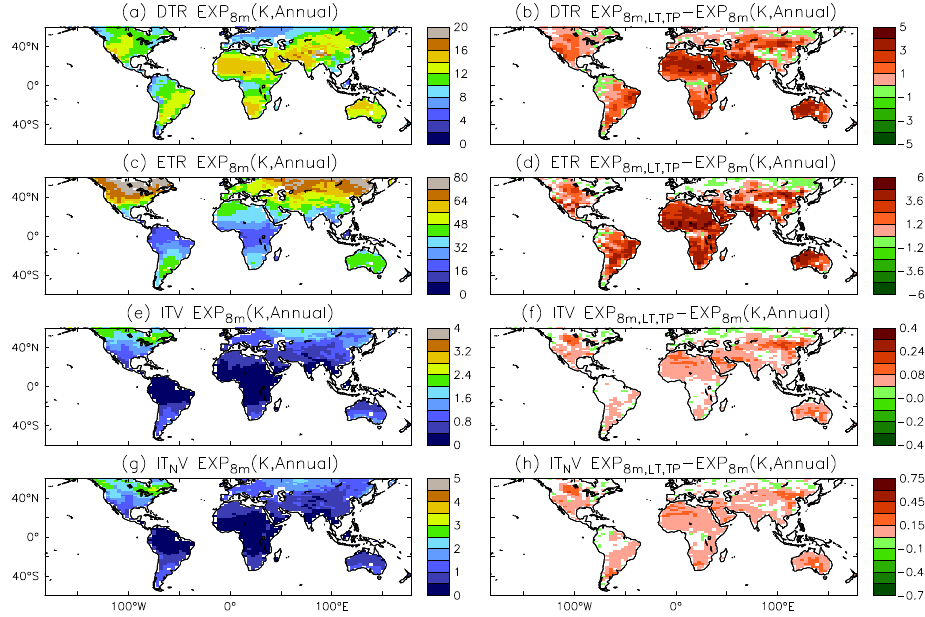
Figure 9. The extreme climate variables for EXP 8m (left) and its difference with EXP 8m , LT , TP (Table 4, right): (a, b) DTR; (c, d) ETR; (e, f) ITV; and (g, h) IT N